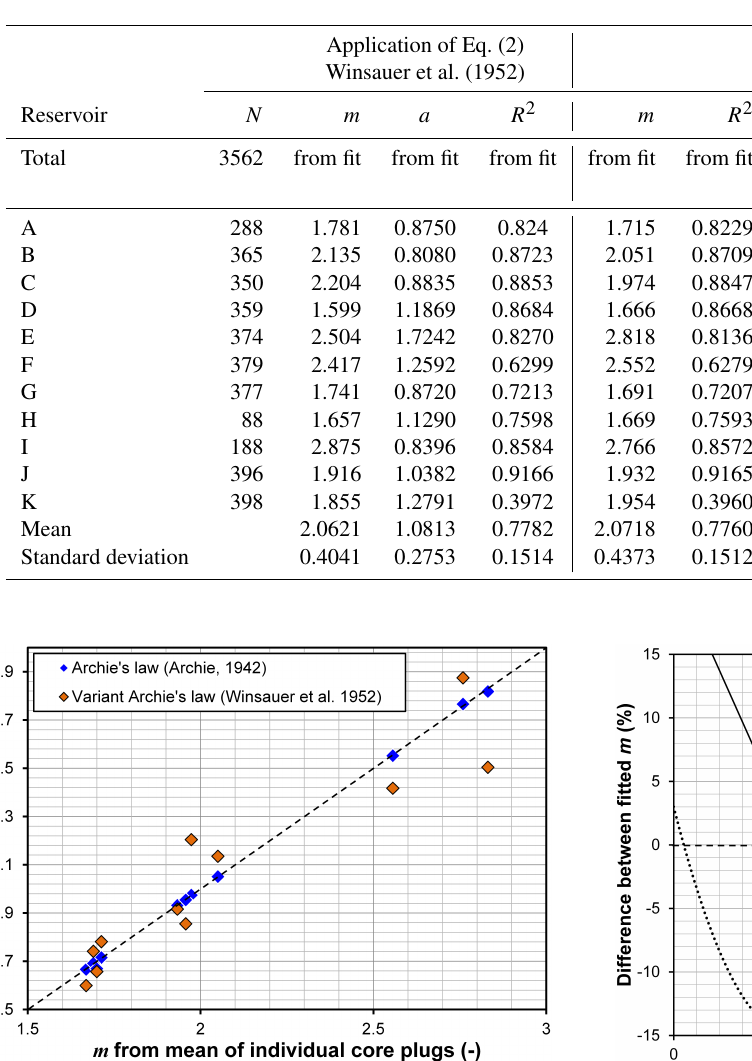
Table 2. Summary data from the 11 test reservoirs.